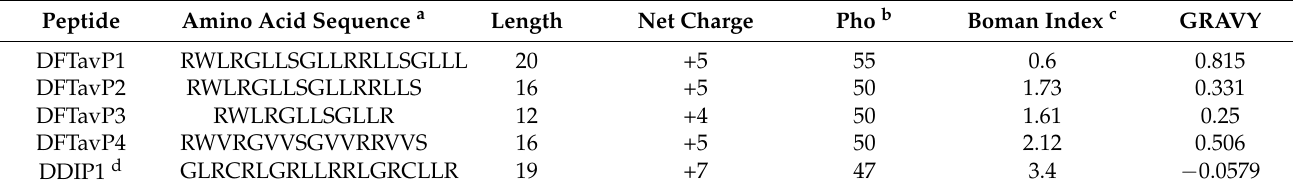
Table 1. Database-designed antiviral peptides and their properties.